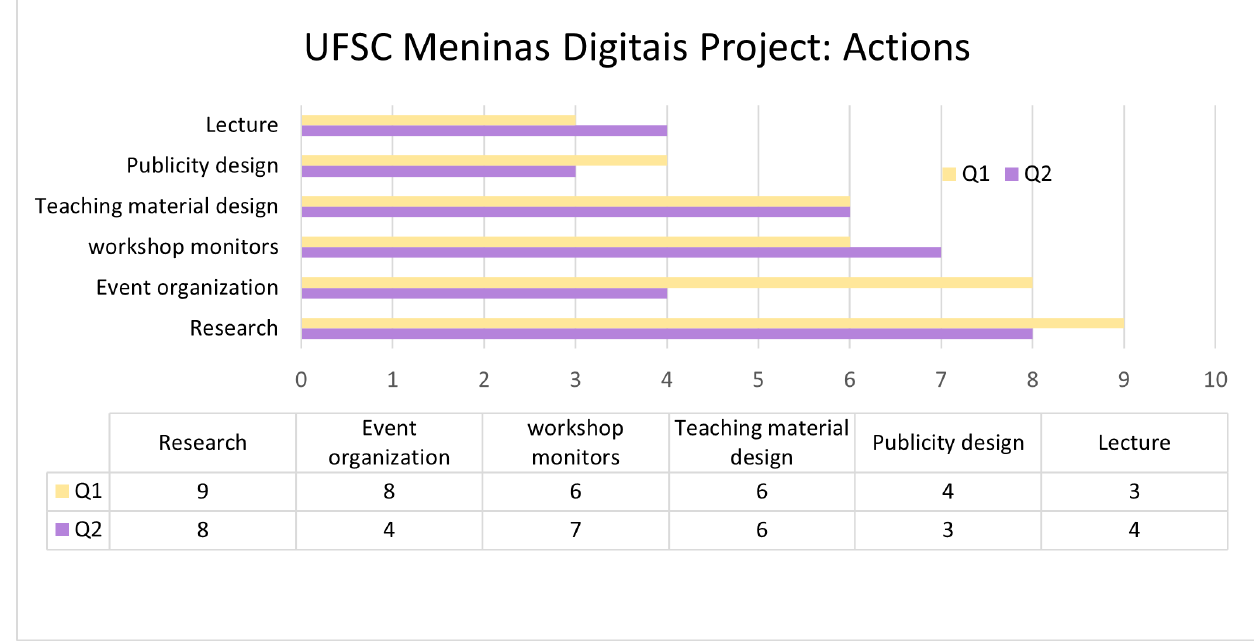
Figure 2. Meninas Digitais UFSC project: Actions (questionnaire 1 and questionnaire